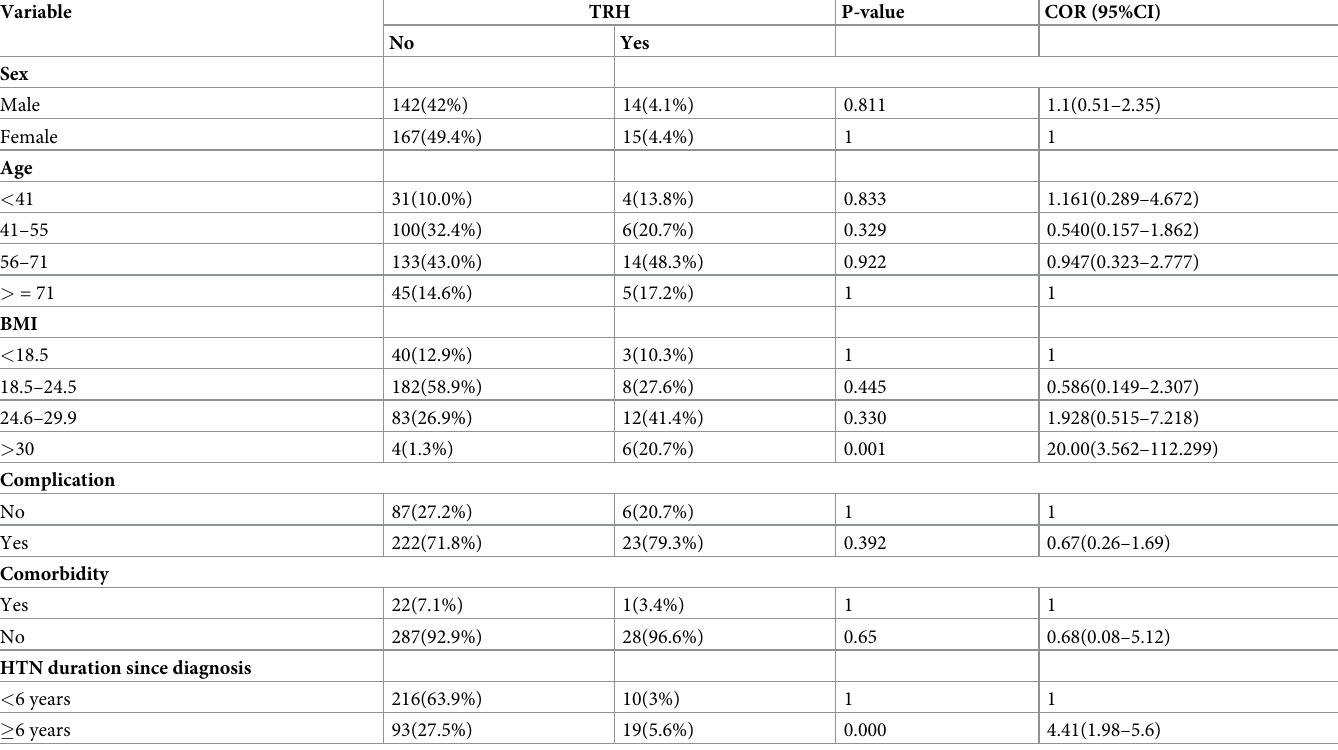
Table 3. Univariate logistic regression analysis of factors associated with treatment resistant hypertension among adult ambulatory hypertensive patients in Mekelle Hospital, 2019.